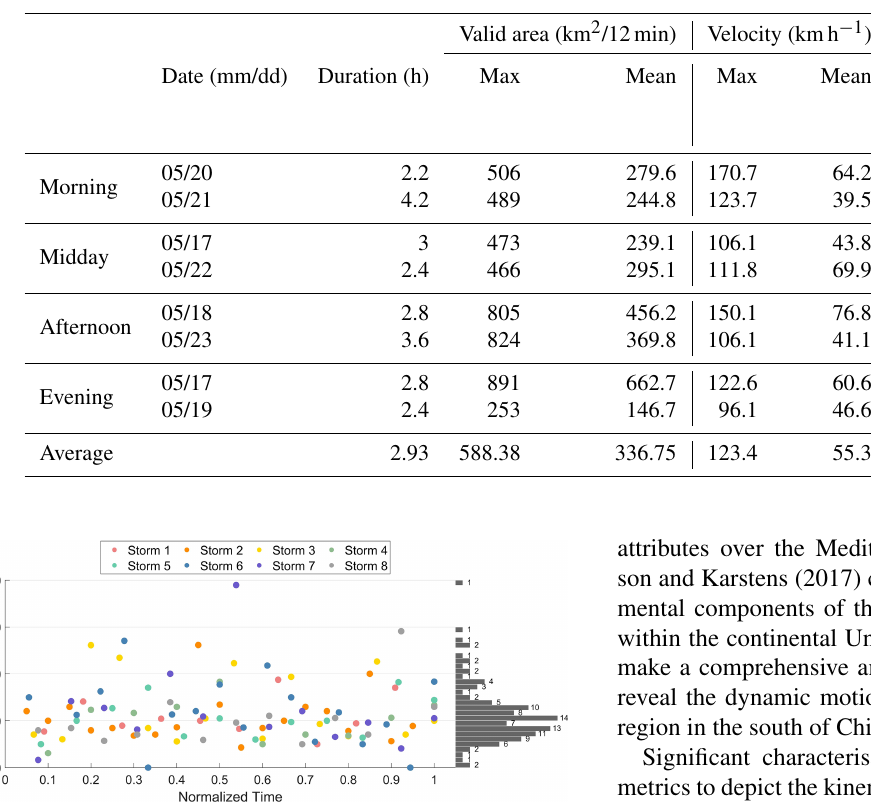
Figure 8. The cluster direction of motion in each interval. The coloured dots denote different thunderstorms. As the duration of thunderstorms is different, the normalised time is used for the gath- ering of all directions of thunderstorm movements. The bar chart on the right represents the frequency of the 10 ◦ angle